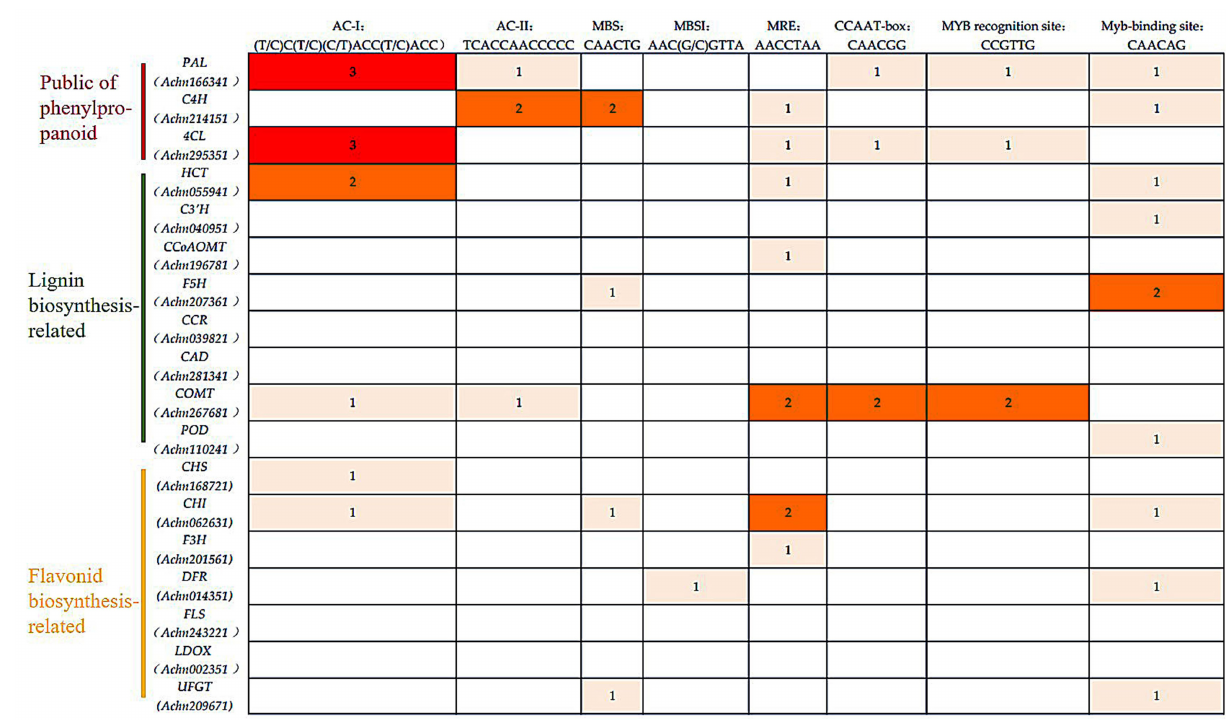
Figure 7. MYB-binding site of the candidate genes from the phenylpropanoid pathway.